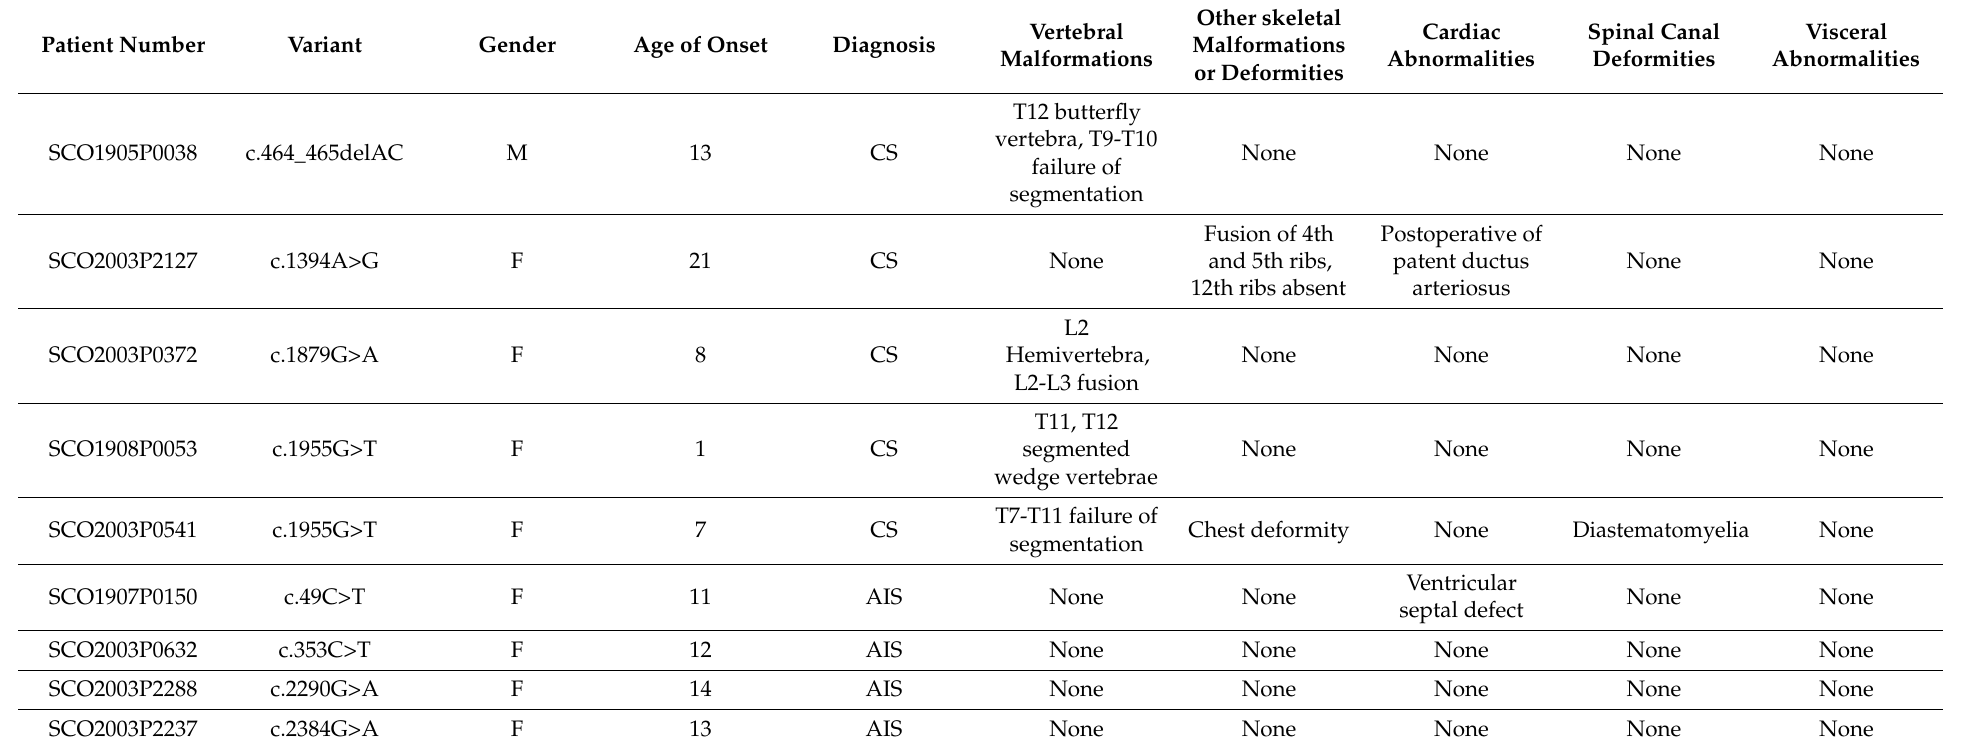
Table 1. Summary of clinical features of the PTK7 variant